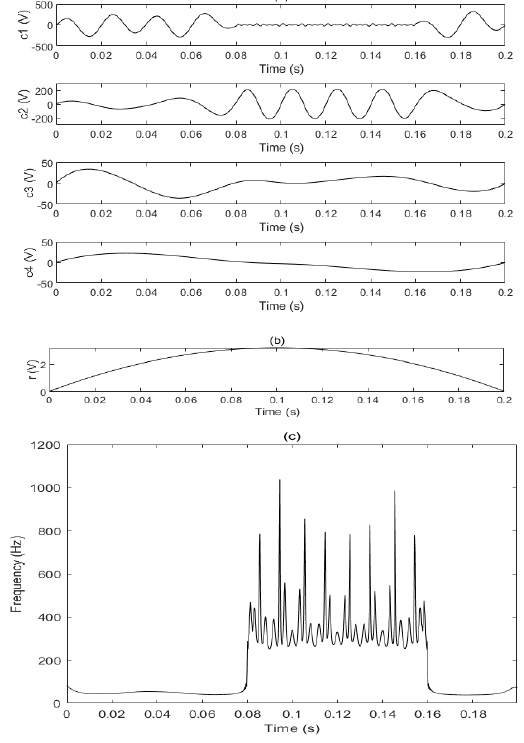
Figure 8. Harmonic IMF components ( a ), margin ( b ), and frequency parameter ( c ).